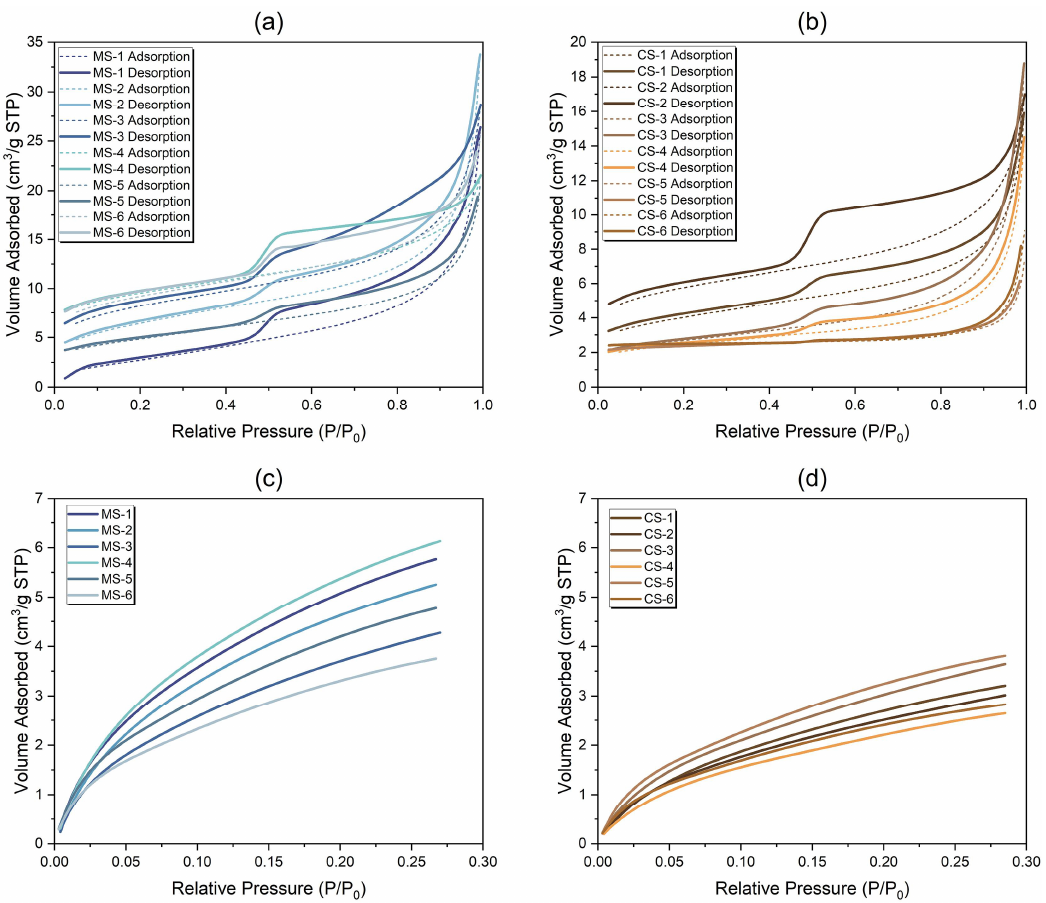
Figure 5. N 2 isothermal adsorption of marine shale ( a ) and continental shale ( b ); CO 2 isothermal adsorption of marine shale ( c ) and continental shale ( d ).